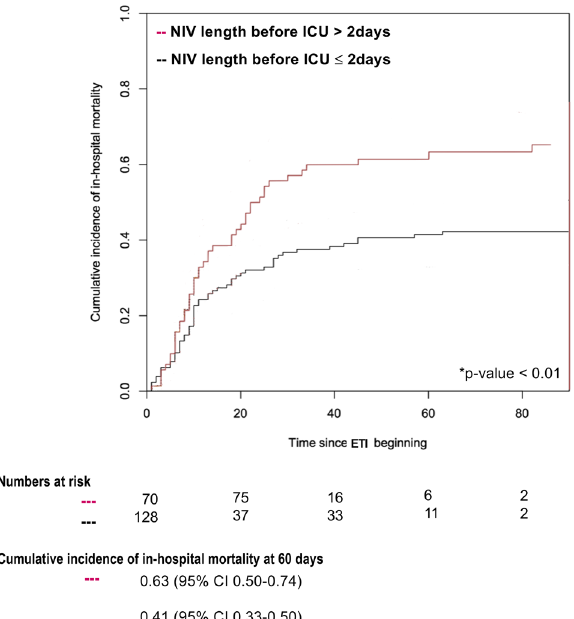
Figure 3. In-hospital mortality stratified by length of NIV application before ICU admission (≤ or > 2 days). p Value Gray’s test was used for calculating equality of cumulative incidence function. The median length of NIV application before ICU admission of non-survivors (= 2 days) was considered as the cut-off value for stratifying patients in two groups. NIV: non-invasive ventilation; ICU: intensive care unit; ETI: endotracheal